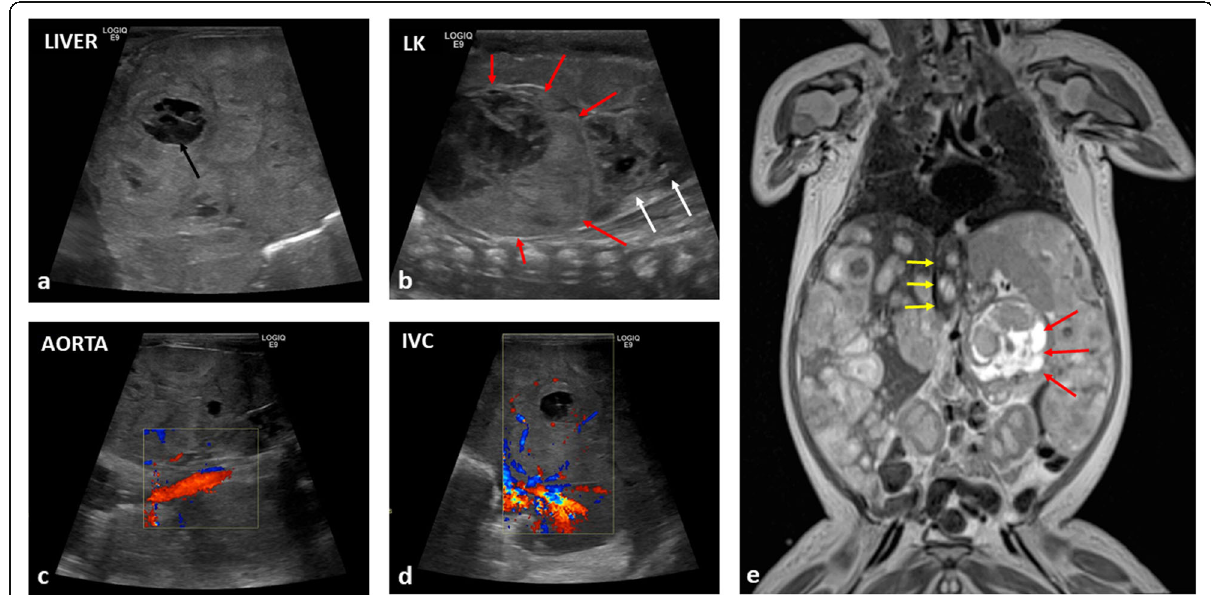
Fig. 11 A newborn boy diagnosed with high risk, neuroblastoma at birth, presenting with abdominal distension, vomiting and discomfort. a Longitudinal ultrasound image of the right lobe of the liver demonstrates heterogenous internal echotexture with the impression of numerous mass-like lesions, some appearing necrotic (black arrow). b A longitudinal view of the left flank reveals a large suprarenal mass (red arrows), causing inferior displacement of the left kidney (white arrows). c Longitudinal views of the aorta demonstrates patency, although those of the ( d ) inferior vena cava only reveal scant flow within the liver. e Coronal T2-weighted MR imaging subsequently confirms the findings, demonstrating the left suprarenal mass (red arrows) with multiple diffuse metastases within the liver. The upper abdominal inferior vena cava is compressed (yellow arrows) putting the patient at risk of abdominal compartment syndrome. The patient also suffered from respiratory compromise from the enlarged liver hindering diaphragmatic movement, hepatic failure, obstructive jaundice and coagulopathy. As a secondary consequence of the large tumour bulk at diagnosis, the patient was also treated for tumour lysis syndrome after initiation of